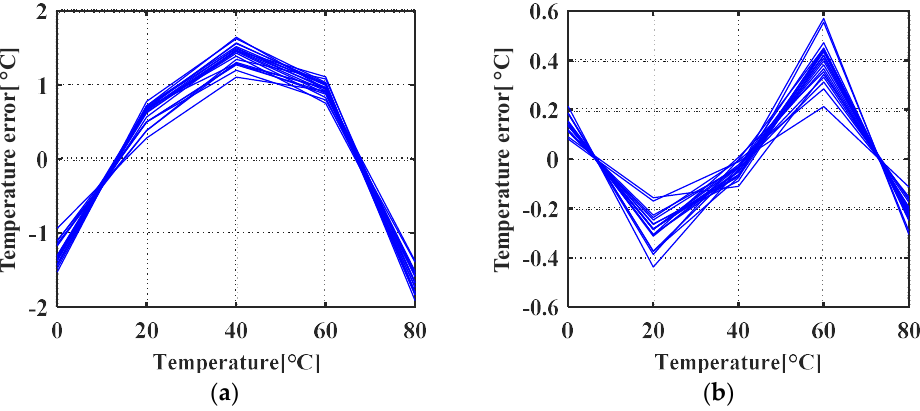
Figure 11. Simulated temperature error ( a ) after 1 st order polyfit, ( b ) after 2 nd order polyfit.